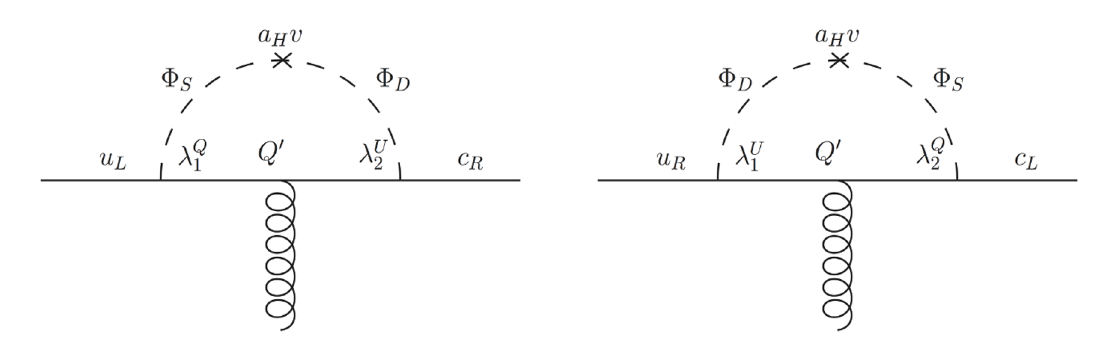
Figure 4 . Diagrams generating j (cid:1) C j = 1 chromo-magnetic dipole